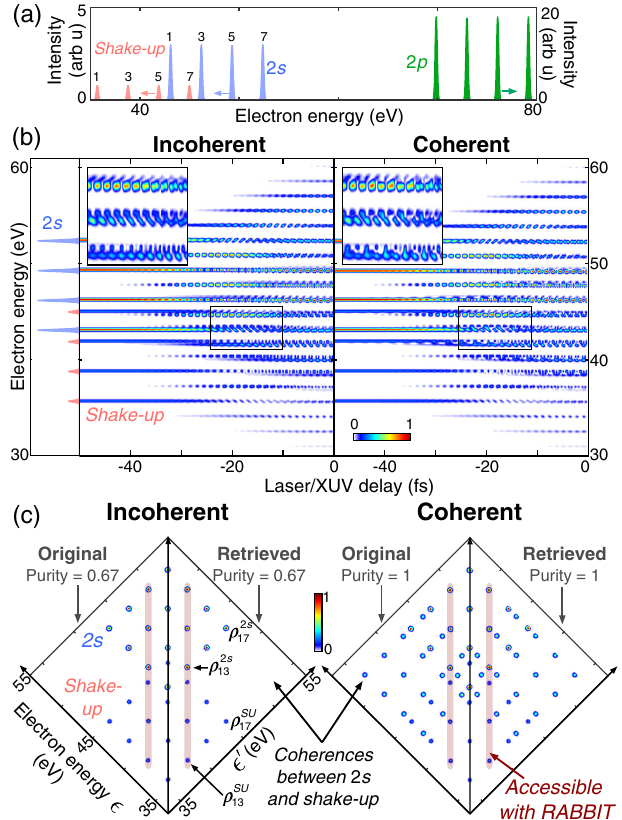
FIG. 5. Simulation of a multichannel photoelectron wave packet reconstructed with Mixed FROG. (a) Electron energy spectrum obtained after ionization of neon by high-order har- monics. The spectrum shows three ionization pathways: direct ionization from the 2 p and 2 s subshells and SU ionization; see the main text for details. (b) Simulated spectrograms in the 30 – 60 eV spectral region with and without interchannel coher- ences between the 2 s and SU wave packets (respectively labeled as the coherent and incoherent cases). The dressing laser pulse has an intensity of 1 . 5 × 10 12 W · cm − 2 and a duration of 27 fs. Inset: Enlargement of the area delimited by the black square in the main panel. (c) Density matrices in the coherent and incoherent scenarios (only the modulus shown). In both cases, the left side corresponds to the original density matrix used to simulate the spectrogram in (b), and the right side shows the density matrix retrieved with Mixed